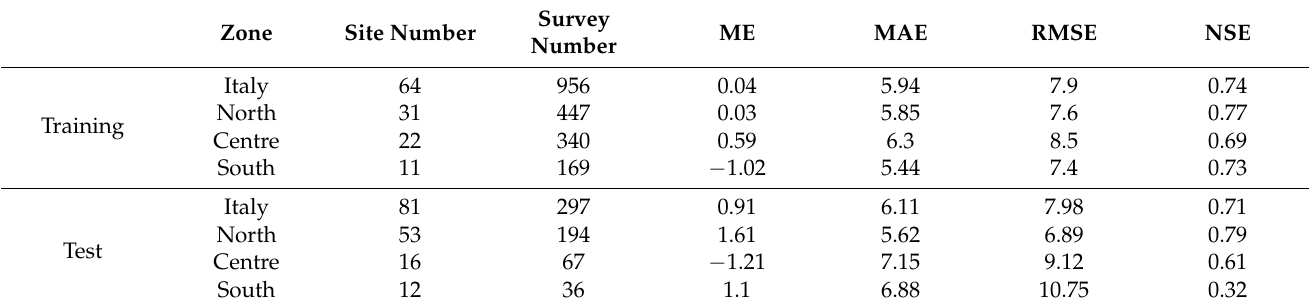
Table 6. Model performance metrics per geographical area. (ME mean error, MAE mean absolute error, RMSE root mean square error, NSE Nash–Sutcliffe Efficiency).